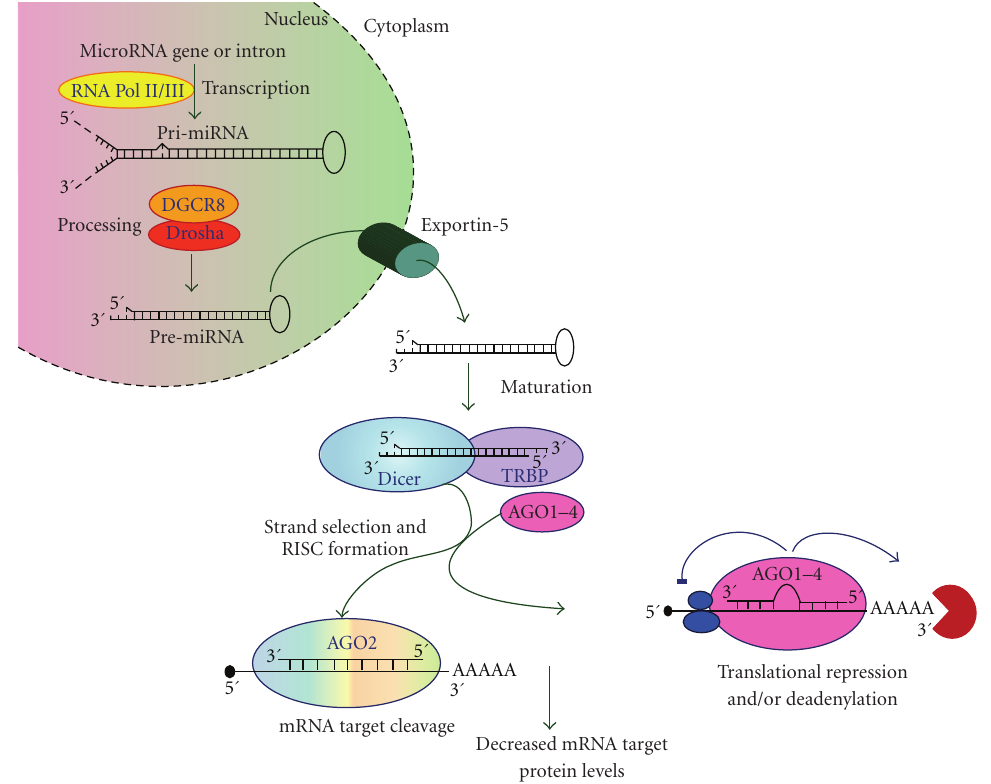
Figure 2: Schematic representation outlining miRNA biogenesis including transcription, maturation, and miRNA/mRNA targeting. This diagram also outlines two potential mechanisms for miRNA/mRNA silencing. The specific details discussing these processes are included in the